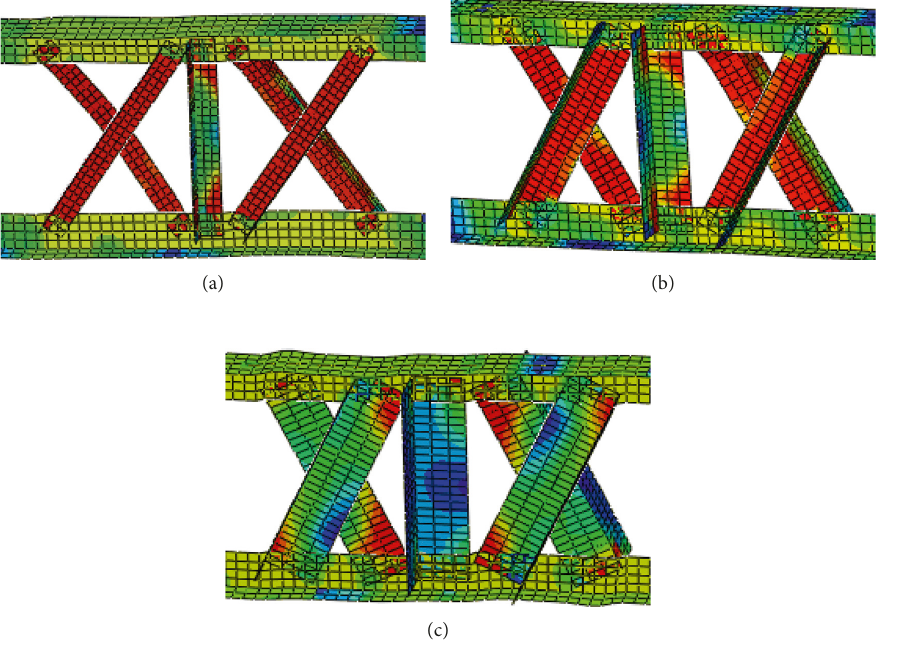
Figure 11: Deformation modes of the coupling beams: (a) type I: ρ III: ρ A > 0 . 65 and ρ K > 0 .